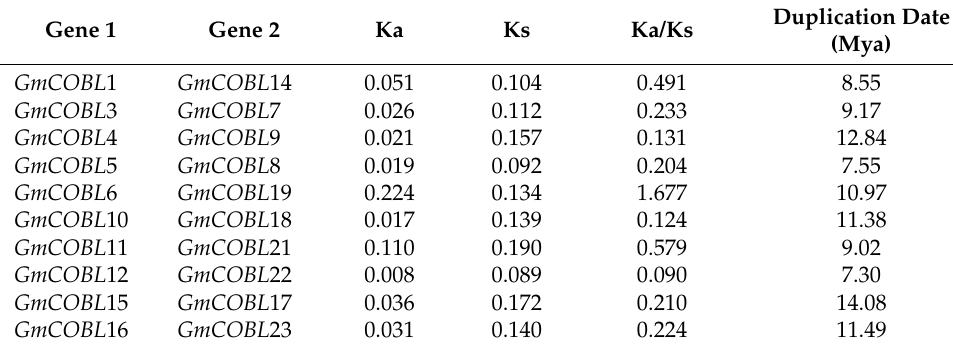
Table 3. The Ka/Ks-ratio values of the paralogs GmCOBL pairs. Mya—million years ago. Gene 1 Gene 2